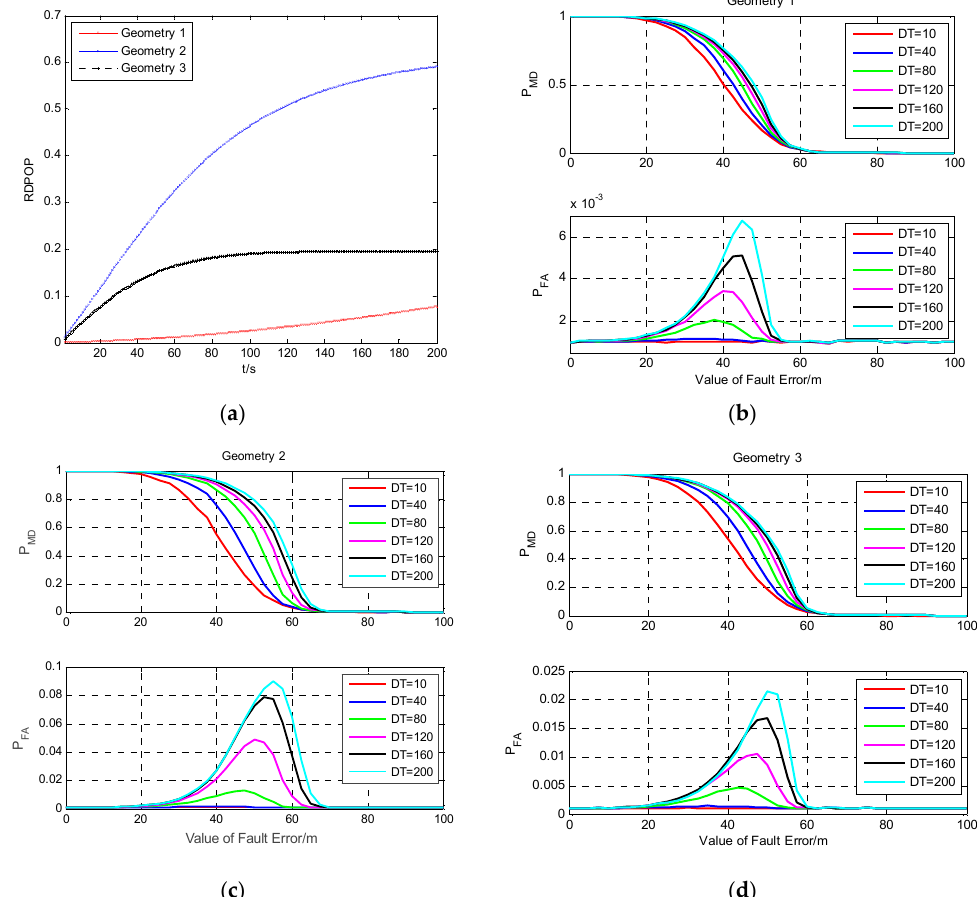
Figure 14. Comparison of the RDPOP of G1 and fault detection results in three geometries. ( a ) The RDPOP of G1 in three geometries; ( b ) Fault detection results in geometry 1; ( c ) Fault detection results in geometry 2; ( d ) Fault detection results in geometry 3.